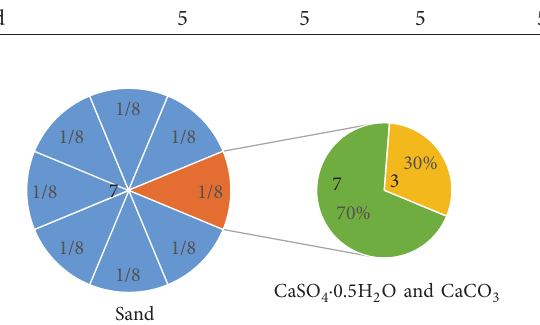
Figure 3: Mixing ratio: 773.